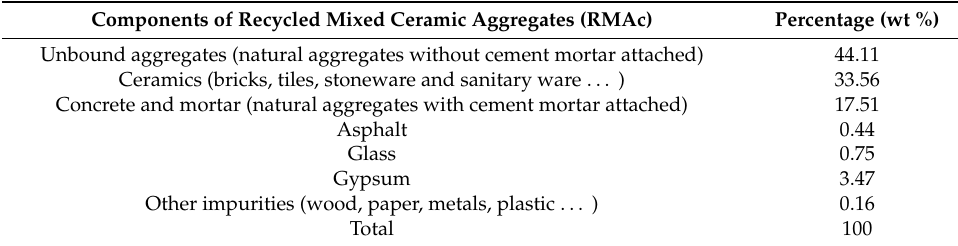
Table 2. Non-floating components of the recycled